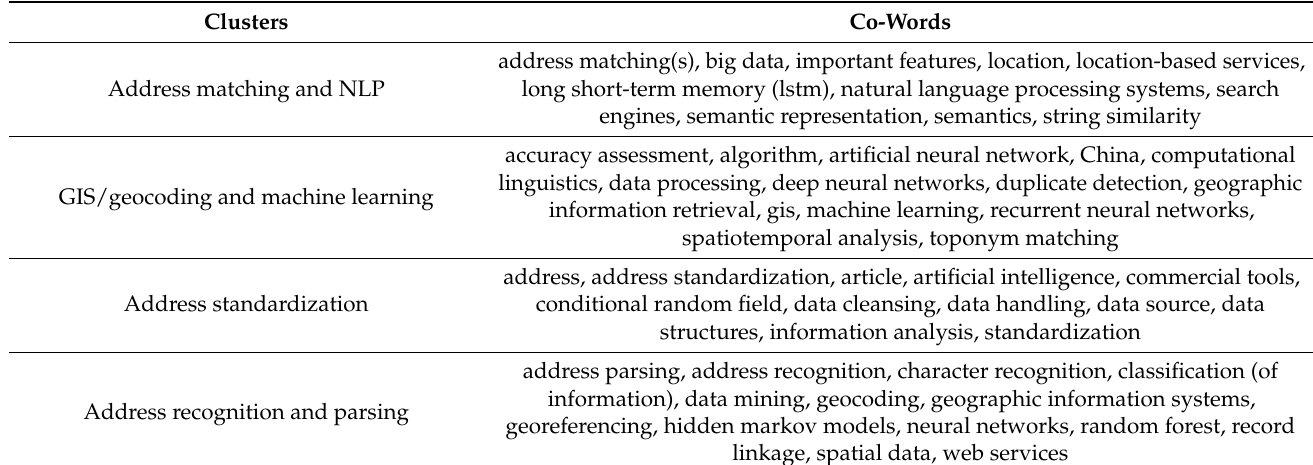
Figure 4. ( a ) Network visualization of keyword occurrence. ( b ) Network overlay of keyword occurrence. Note: Circles represent keywords and their size represents the keywords’ importance. Clusters are identified by circles sharing the same color and the thickness of the link connecting the circles corresponds to the number of times two connected nodes are mentioned together. An earlier time is represented by a color closer to blue and a more recent year by a color closer to yellow. As shown in Table 4, four clusters were identified, based on VOSviewer default cluster- ing technique [17]: address matching and NLP, in green (e.g.,: Xu et al. [20]), GIS/geocoding and machine learning, in blue (e.g.,: Peng et al. [21]), address standardization, in yellow (e.g.,: Churches et al. [6]) and address recognition and parsing, in red (e.g.,: Wei et al. [22]). Table 4. Co-words obtained in each cluster by